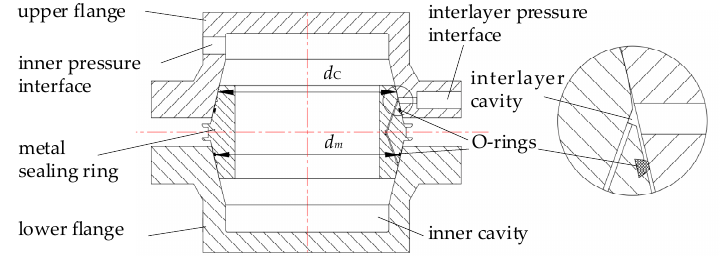
Figure 10. Schematic diagram of clamp connector contact sealing test.